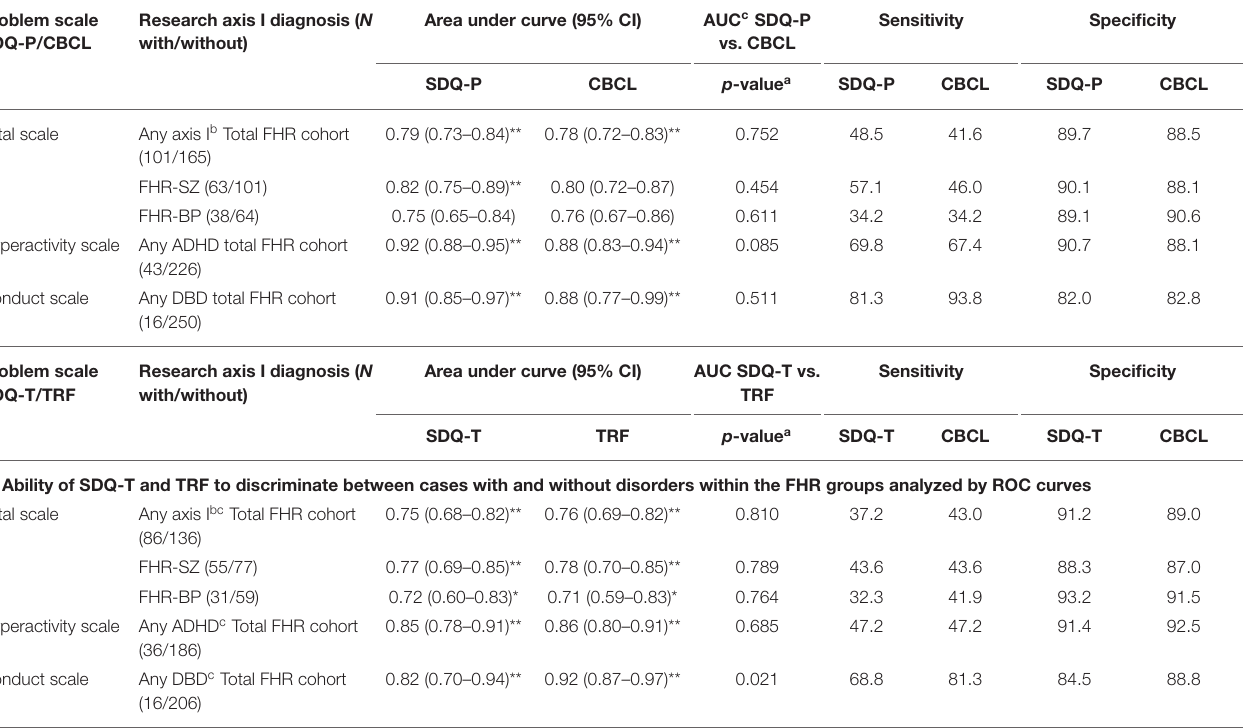
TABLE 4 | A. Ability of SDQ-P and CBCL to discriminate between cases with and without disorders within the FHR groups analyzed by ROC curves. Problem scale Research axis I diagnosis ( N Area under curve (95% CI) AUC c SDQ-P SDQ-P/CBCL with/without)